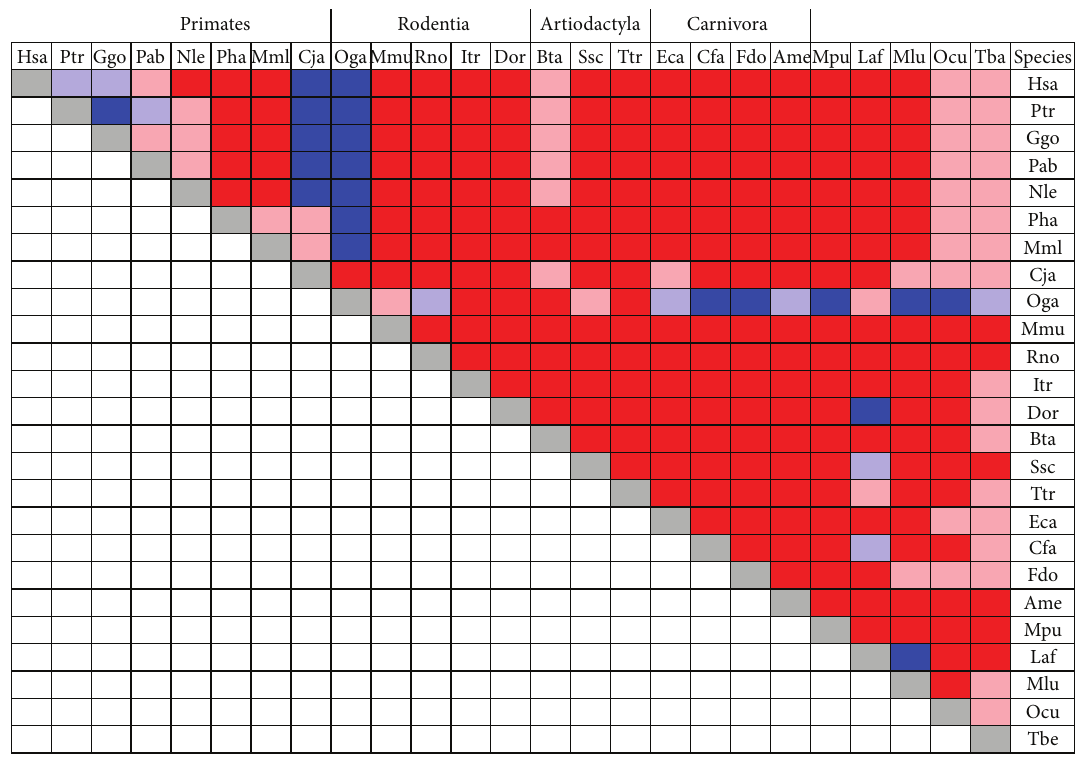
Figure 3: Pairwise dN/dS ratios among all 25 mammalian species in this study. Red represents 0.0 < dN/dS < 0.5. The pink entries represent 0.5 < dN/dS < 1.0; light blue represents 1.0 < dN/dS < 2.0; dark blue represents dN/dS > 2.0. Species abbreviations are given in the text. Crown orders containing more than a single representative are grouped